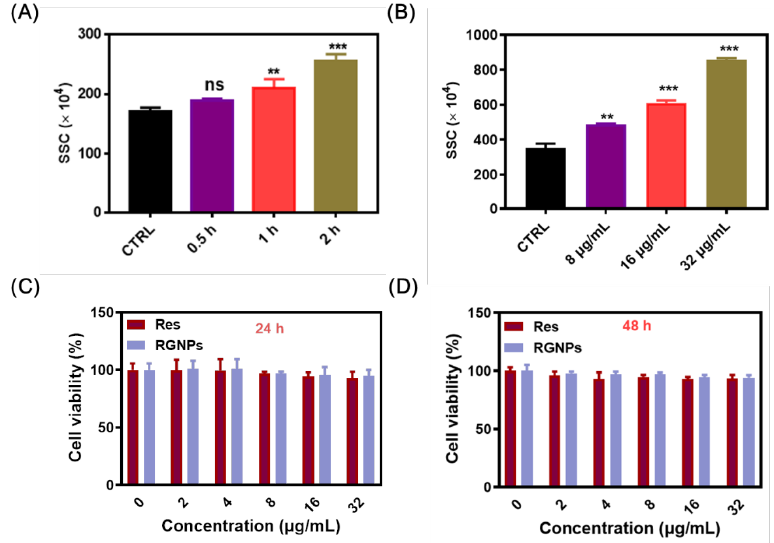
Figure 2. Cellular uptake in vitro. ( A ) Side scatter (SSC) values of HLECB3 cells treated with RGNPs with different incubation times via flow cytometry (FCM) analysis. ( B ) SSC values of HLECB3 cells treated with different concentrations of RGNPs via FCM analysis. ( C ) Cell viability of HLECB3 cells treated with different concentrations of RGNPs for 24 h. ( D ) Cell viability of HLECB3 cells treated with different concentrations of RGNPs for 48 h. ** and *** indicate p < 0.01 and p < 0.001; ns indicated statistically insignificant.